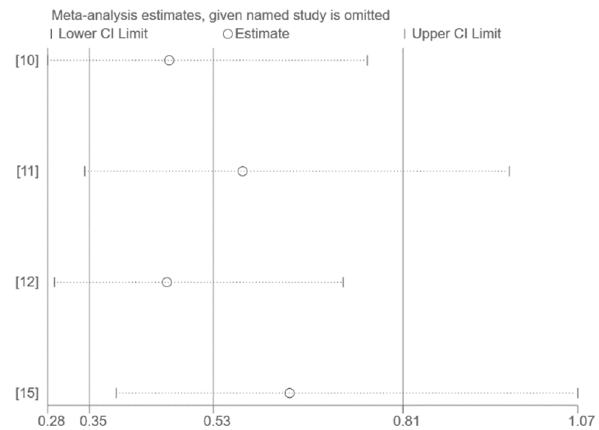
Figure 4. Sensitivity analysis (only Delta) [9,11,13–15].